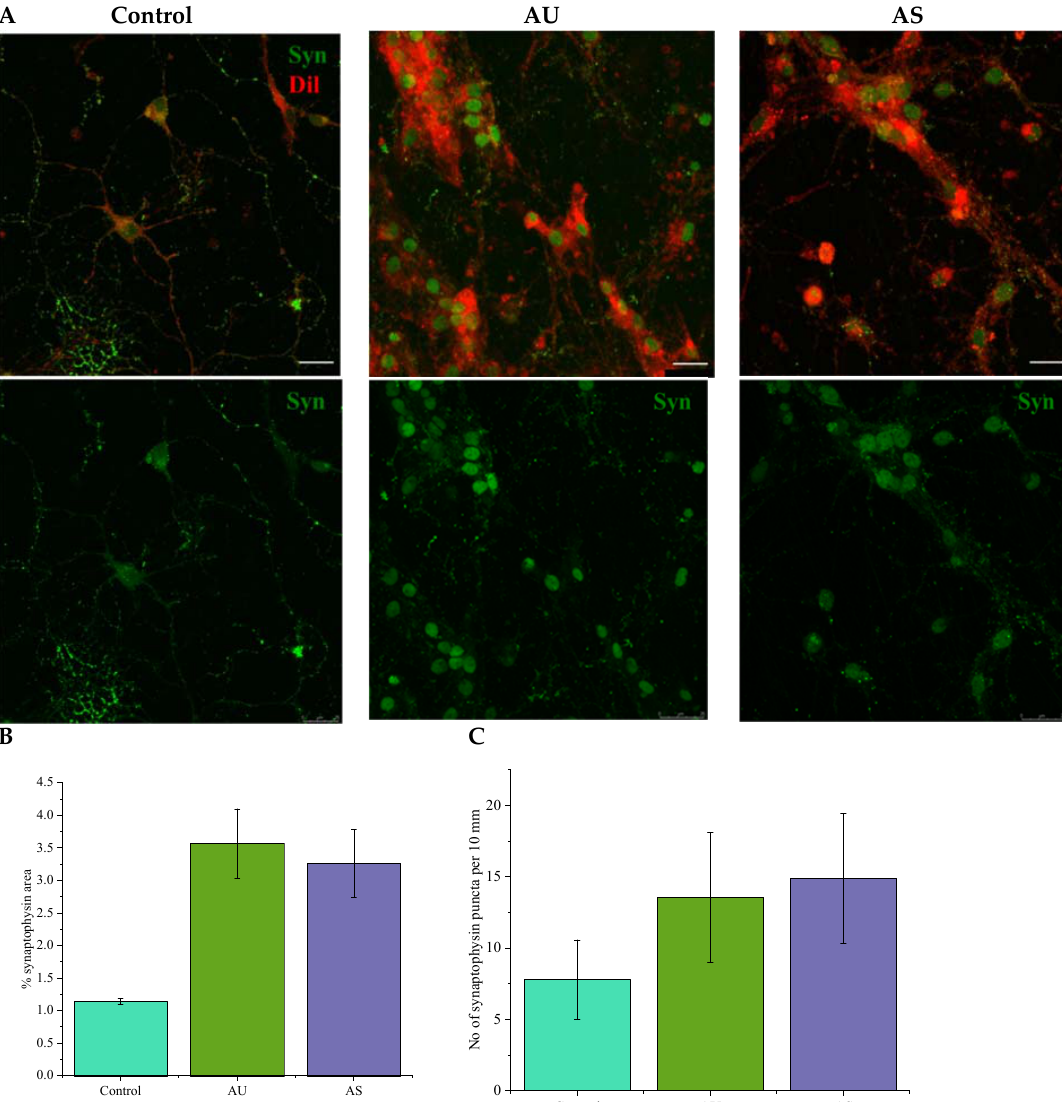
Figure 8. The effect of scaffold structure on the number of synapses formed by neurons. ( A ) Representative images of hippocampal neurons stained for synaptophysin (green) on glass, AU and AS nanofibers (scale bar—25 µ m); ( B ) percentage of the area occupied by stained synaptophysin puncta from the area of the cell; ( C ) quantification of synaptophysin puncta on 10 µ m